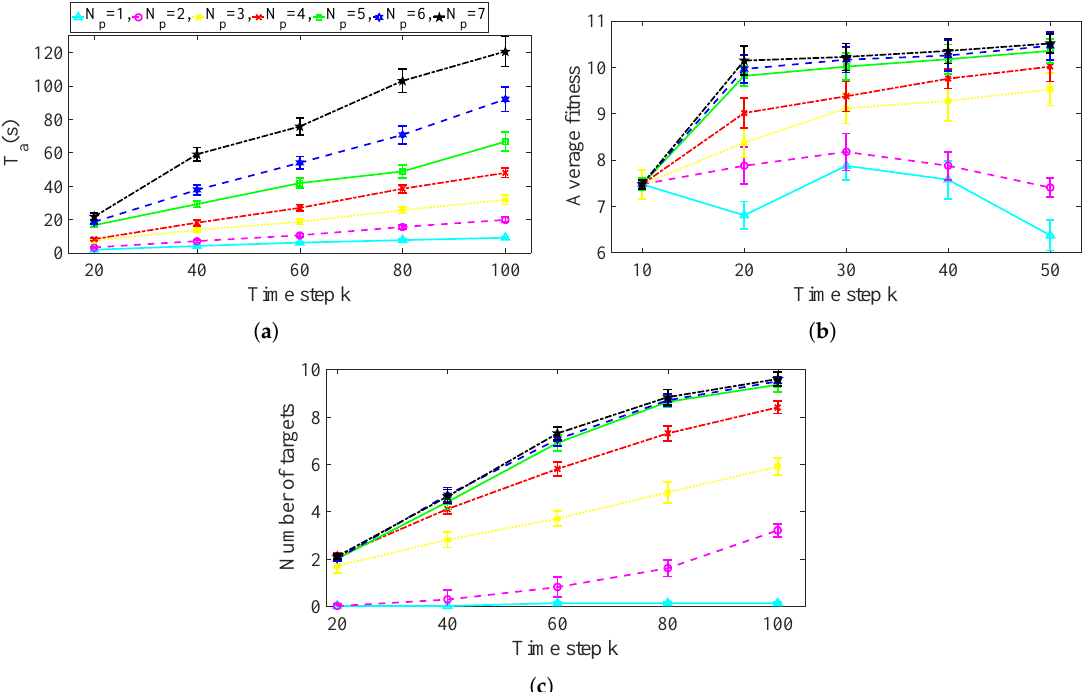
Figure 6. Error analysis for different values of N p : ( a ) Running time; ( b ) Average fitness value; ( c ) Number of targets